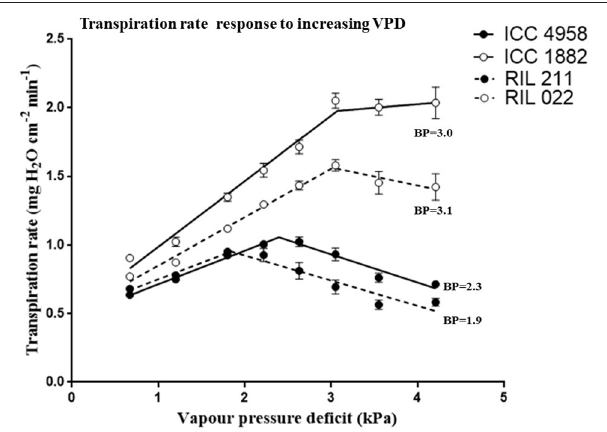
FIGURE 2 | Transpiration rate (TR mg cm − 2 min − 1 ) response to increasing VPD conditions in four chickpea genotypes contrasting for plant vigor. The early vigor genotypes ICC 4958 (solid line with closed symbols) and RIL 211 (dashed line with closed symbols) showed earlier or lower VPD breakpoint values (2.3 and 1.9 kPa). The late vigor genotypes ICC 1882 (solid line with open symbols) and RIL 022 (dashedline with open symbols) showed higher VPD breakpoint (BP) values (3.0 and 3.1 kPa). Each data point represents the means ( ± SE) of 10 replicates per